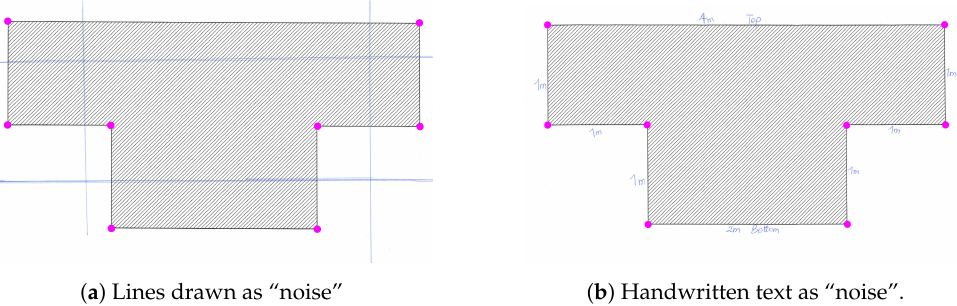
Figure 4. Influence of “noise” on the detection of the corner points; ( a ) shows lines drawn over the cross-section; ( b ) shows handwritten text on